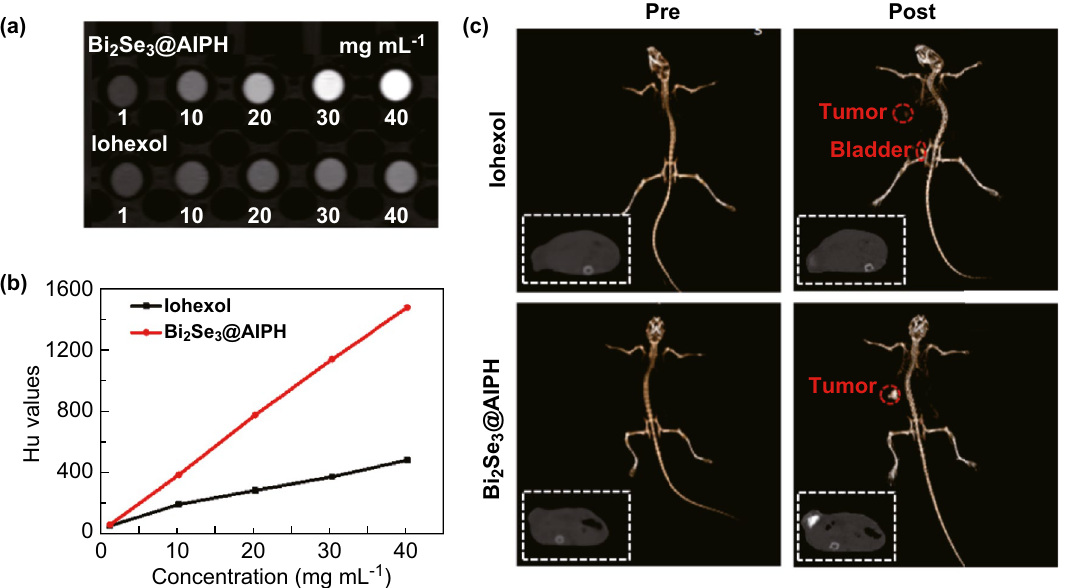
Fig. 4 In vitro and in vivo CT imaging. a The in vitro CT imaging pictures and b quantitative HU values of Bi 2 Se 3 @AIPH NPs and iohexol at the concentrations of 1, 10, 20, 30, and 40 mg mL −1 . c The 2D sectional imaging and 3D reconstruction pictures before and after the injection